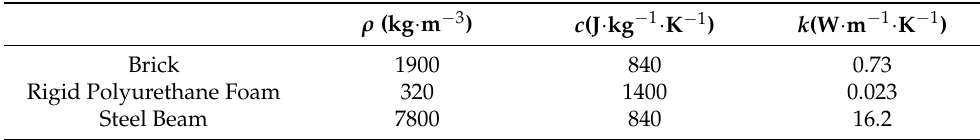
on the right and lower sides. The obtained meshes are shown in Figure 10.